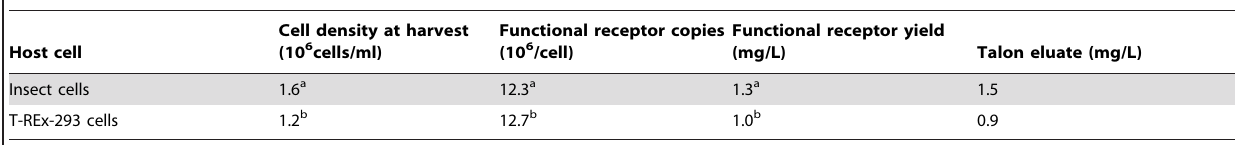
Table 1. Purification of NTS1 from different host cells.